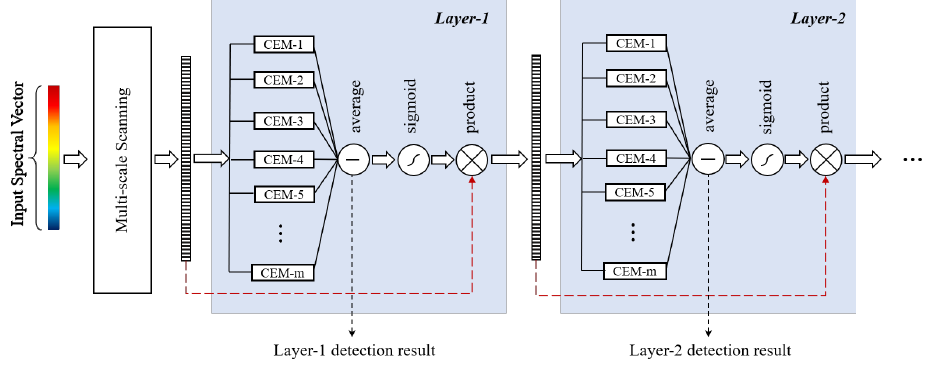
Figure 1. An overview of the E-CEM